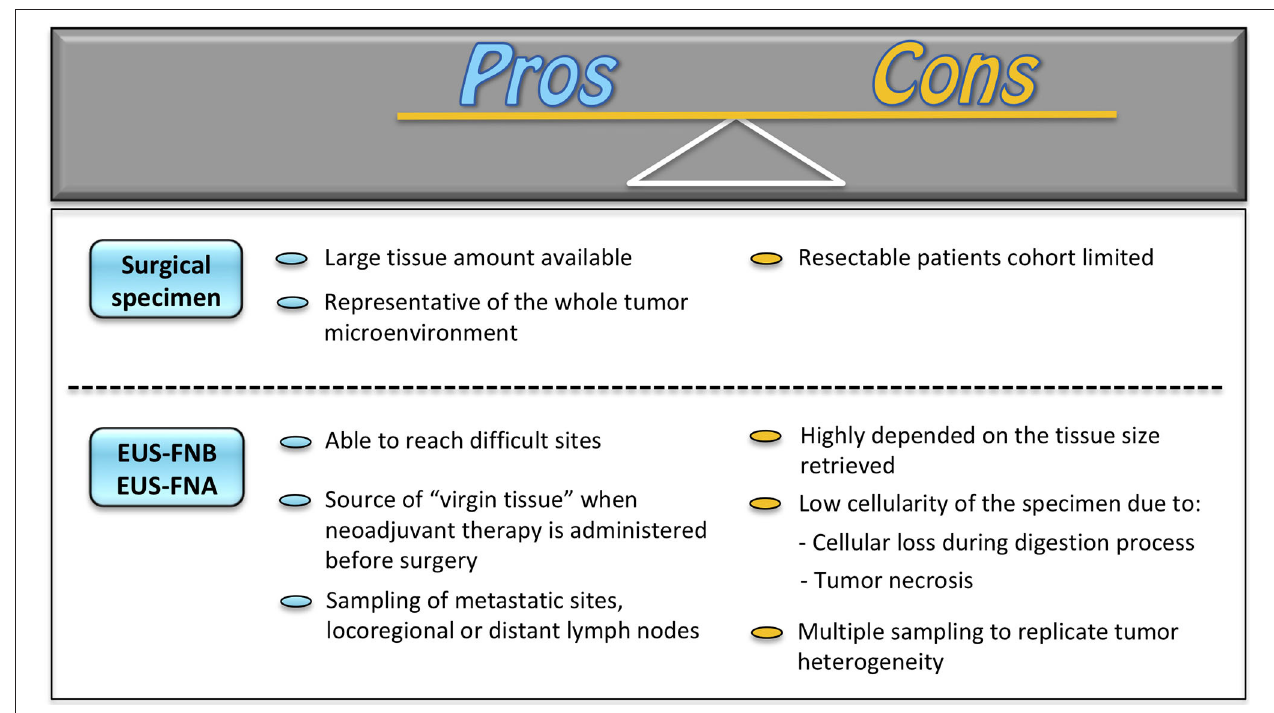
FIGURE 1 | Surgery vs. EUS technics for PDO platform generation. EUS-FNA, EUS-guided fine needle aspiration; EUS-FNB, EUS-guided fine needle biopsy.